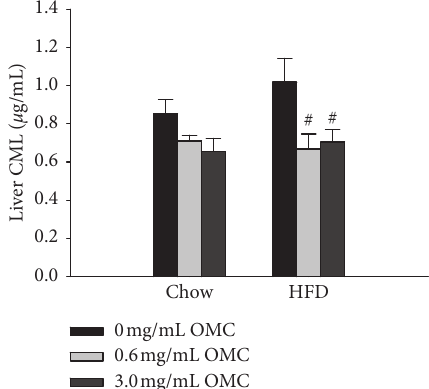
Figure 3: Liver N ε -(carboxymethyl)lysine concentrations. Data are expressed as mean ± SEM and analyzed by two-way ANOVA, n � 6/ treatment group, # p < 0 . 05 vs. HFD